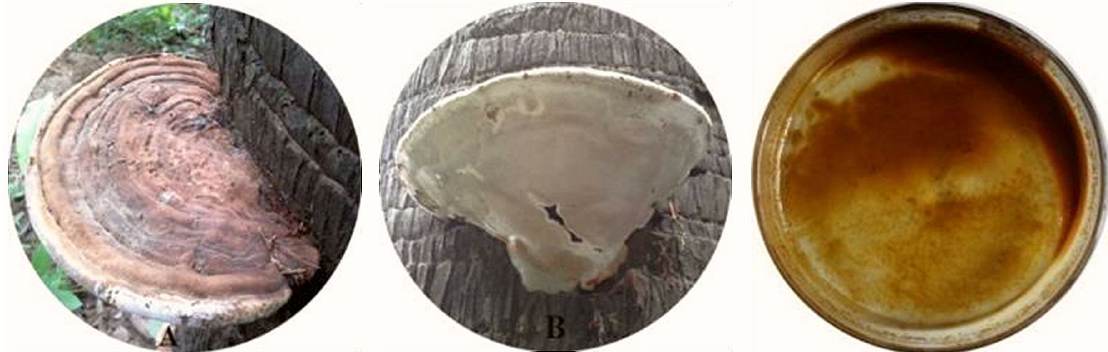
Fig. 1. Fruiting body of G. applanatum (A and B) and extract